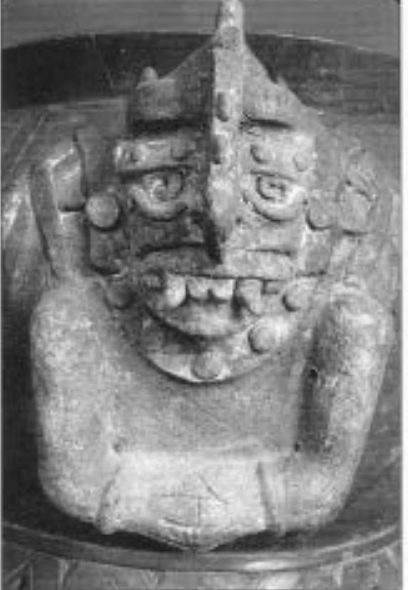
Figure 8 A Postclassic large pottery jar showing the distinctive iconography of the period, probably twelfth centmy